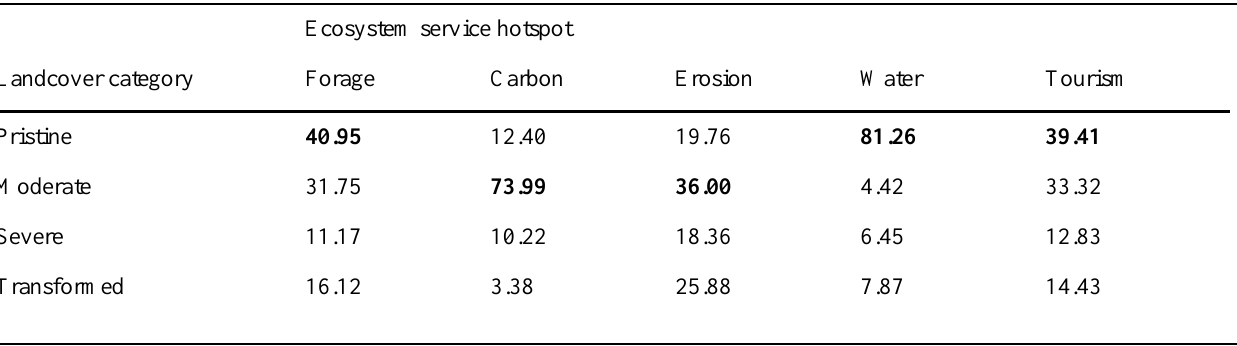
Table 2. Land-cover composition of ecosystem service hotspots shown as a percentage of the total